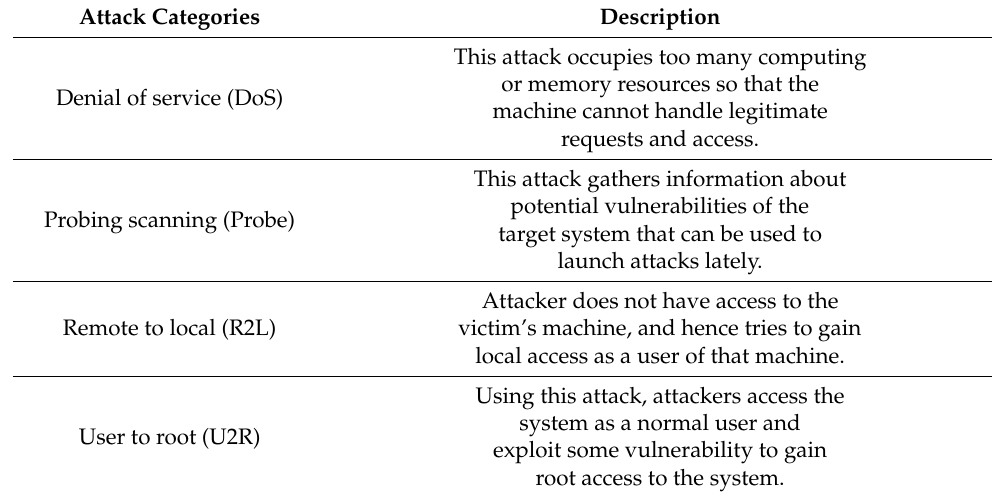
Table 3. The description of attacks.